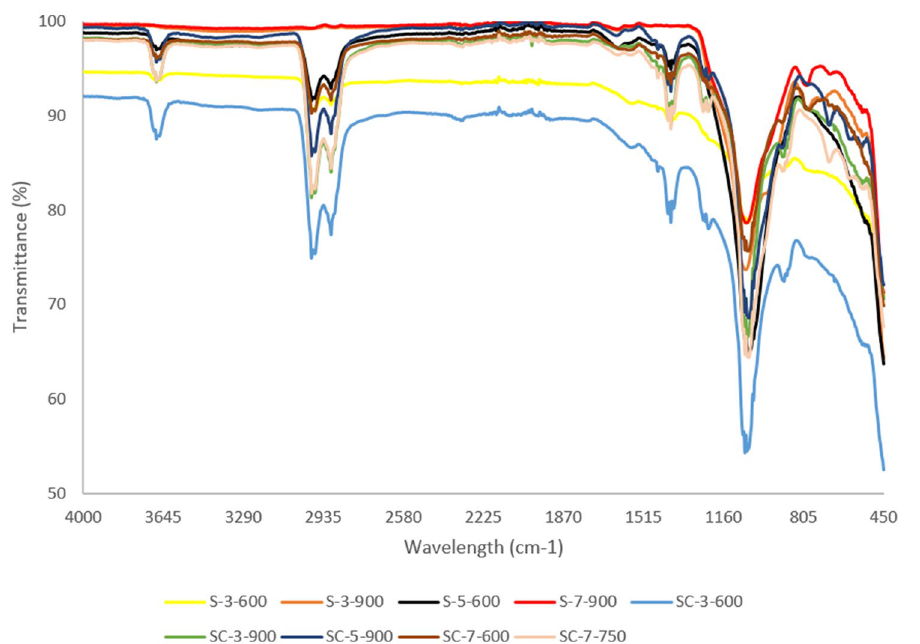
Figure 8. FT-IR spectra of SBAC obtained from raw sewage sludge S as